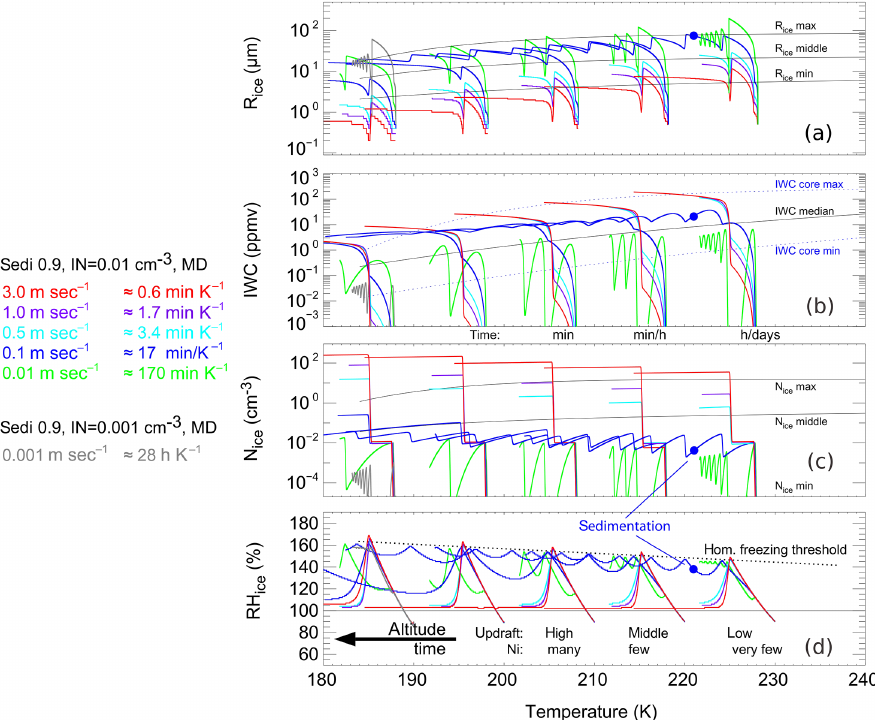
Figure 5. Cirrus scenario HET+HOM | 0 . 01 − MD : simulated evolution of cirrus clouds at different temperatures and varying vertical velocities sedi − 0 . 9 (see legend). The simulations propagate from right to left, the time of the simulations is indicated in the legend (in minK − 1 ). (a) R ice (lines: min, middle, max R ice from Krämer et al., 2009), (b) IWC (solid line: median IWC, dotted lines: upper and lower bound of the core IWC band from observations of Schiller et al., 2008 and Luebke et al., 2013), (c) N ice (lines: min, middle, max N ice from Krämer et al., 2009), (d) RH ice